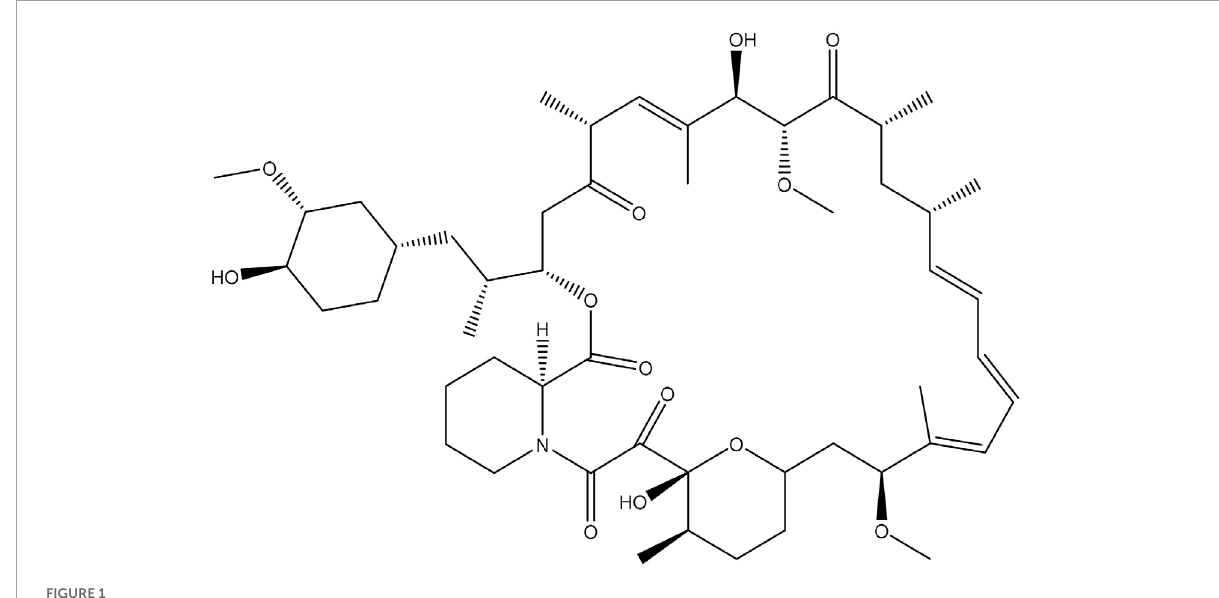
FIGURE1 Chemical structure of